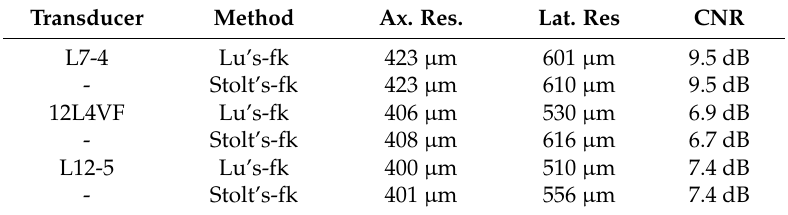
Table A3. Axial and lateral resolution, and CNR by Lu’s-fk and Stolt’s-fk without angular weighting.